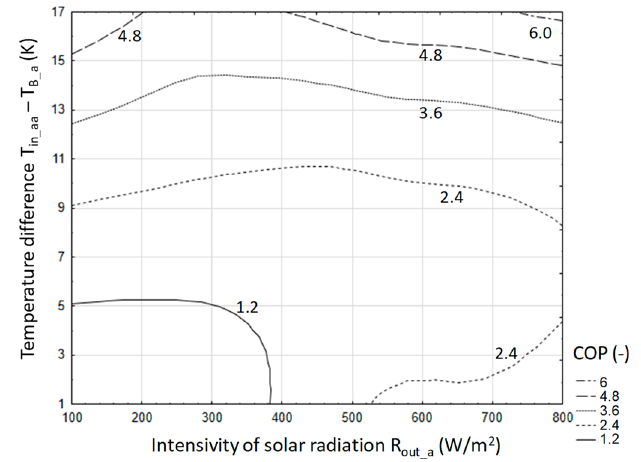
Figure 28. Energy efficiency of heat storage depending on temperature difference and solar radiation